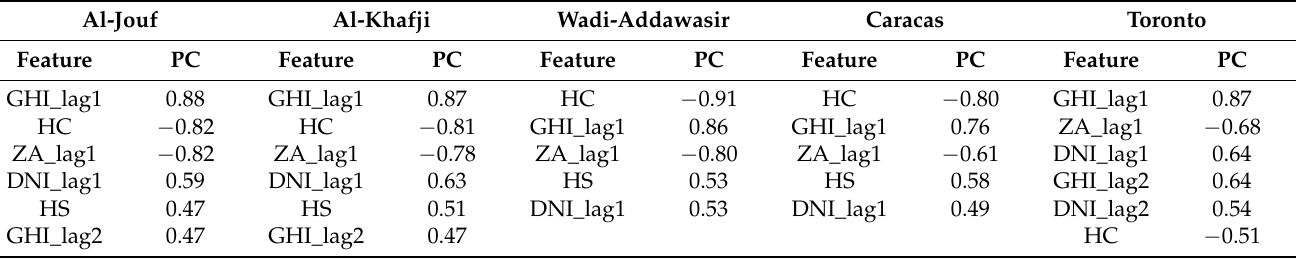
Table 7. Significant Pearson’s correlation (PC) between GHI and other